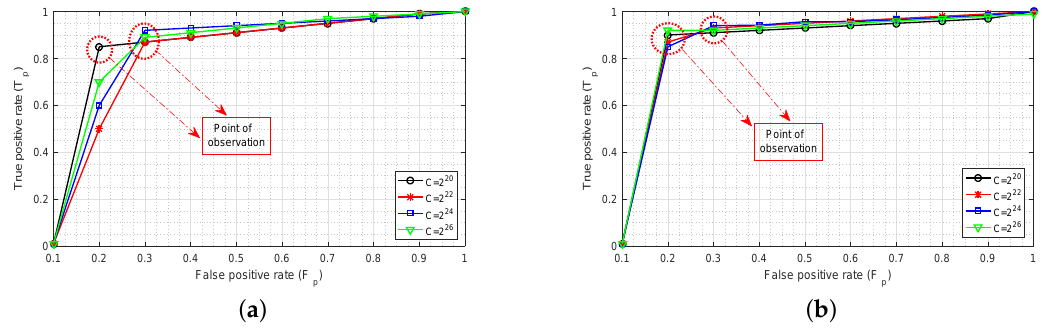
Figure 4. Receiver operating characteristics (ROC) curves: ( a ) test set corresponding to Training Set 1 for different C values; ( b ) test set corresponding to Training Set 2 for different C